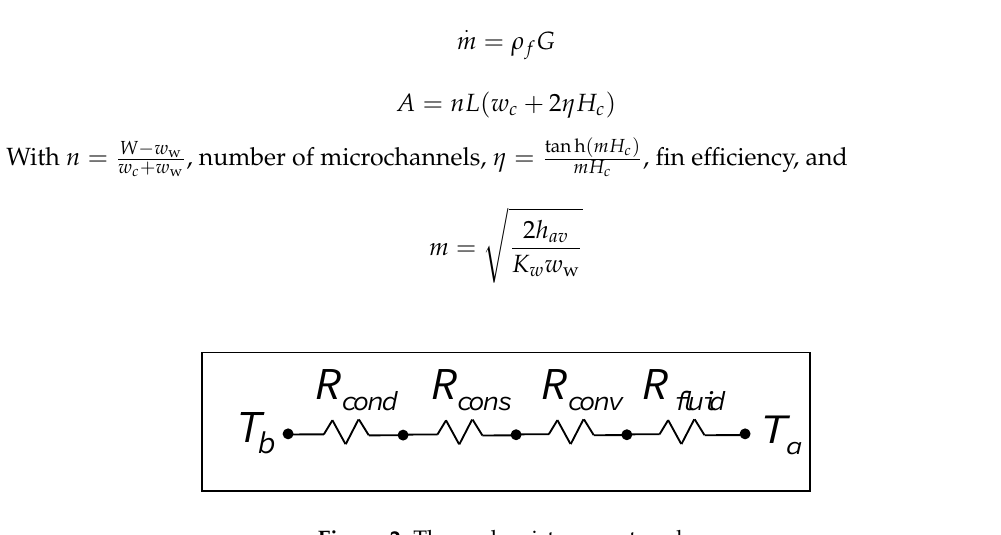
Figure 2. Thermal resistance network.